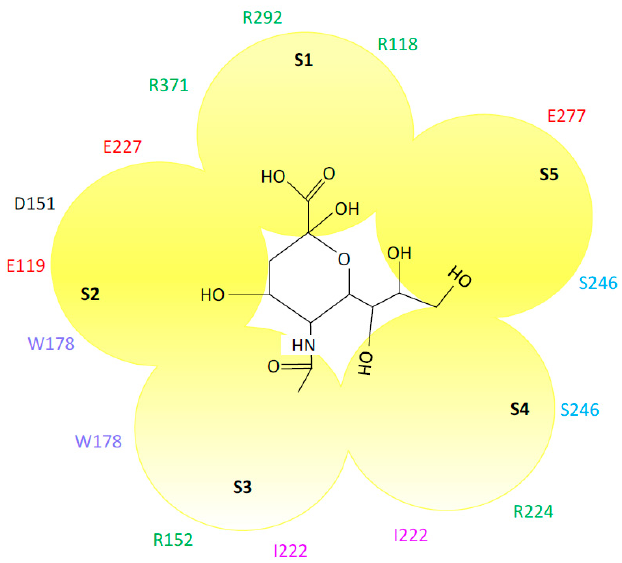
Figure 1. Interaction of the neuraminidase active site with sialic acid. The interacting amino acids and the active site subsites (S1–S5) are shown (N2 numbering). Glutamic acid (red), serine (blue), arginine (green), tryptophan (violet) and aspartic acid (black). Sialic acid is shown in the center of the figure. Adapted from References [8,9]. Sialic acid structure was adapted from PubChem.